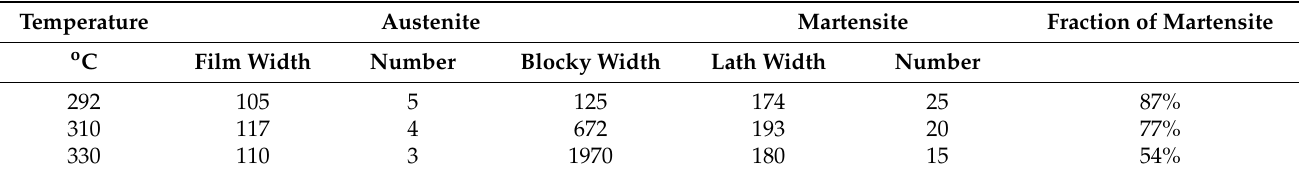
Table 2. Width and number of the austenite and martensitic lath and corresponding martensite volume fraction at different quenching